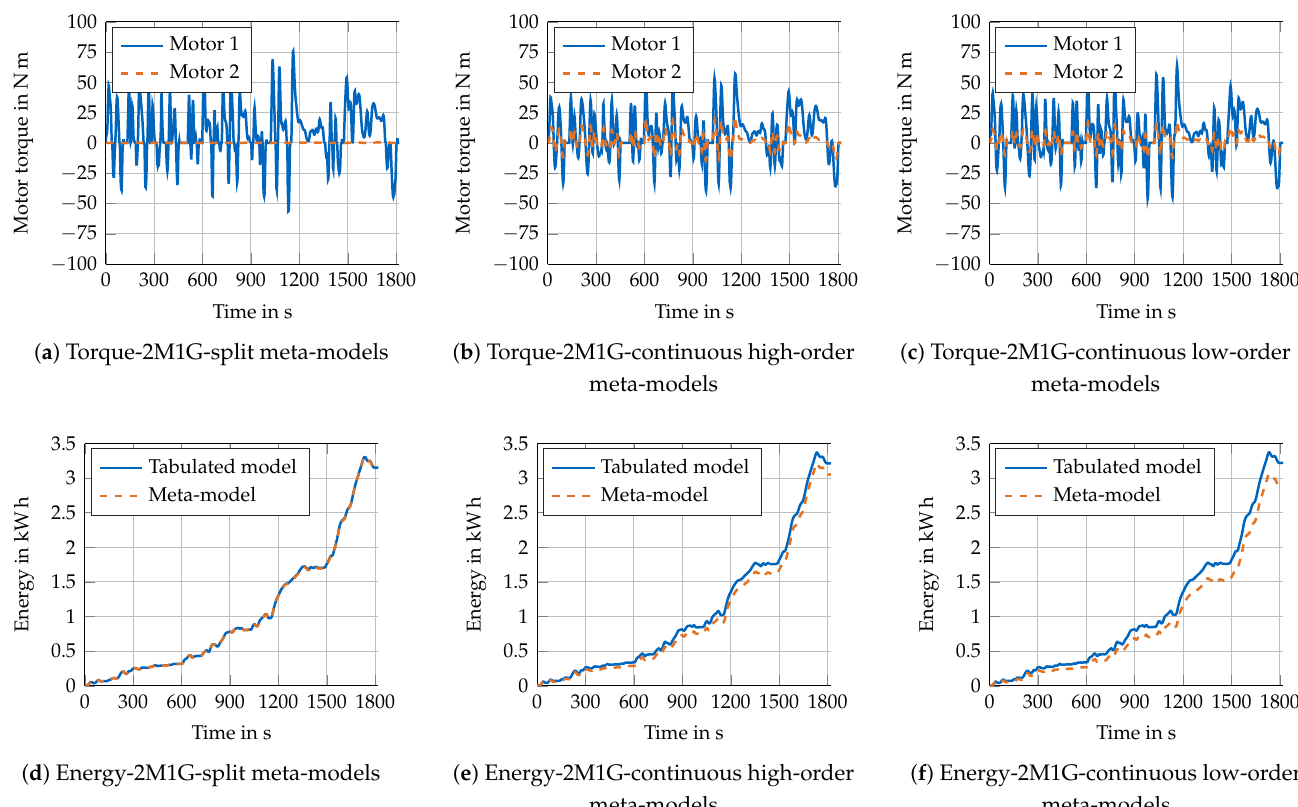
Figure 7. ( a – c ): Torque division between the two motors of the 2M1G topology based on the split meta-models, continuous high-order meta-models and continuous low-order meta-models. ( d – f ): Energy consumption of simulation (tabulated models) and optimization (meta-models) for the 2M1G-